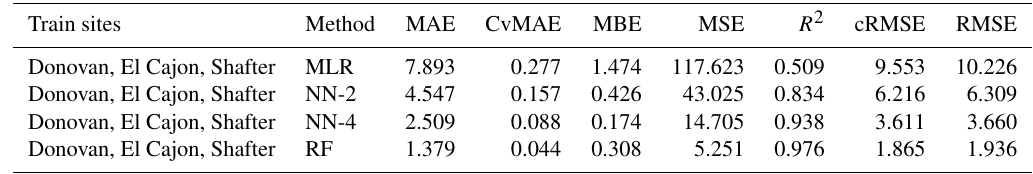
Table C15. Level 3 train results for O 3 (train and test on the same data set).